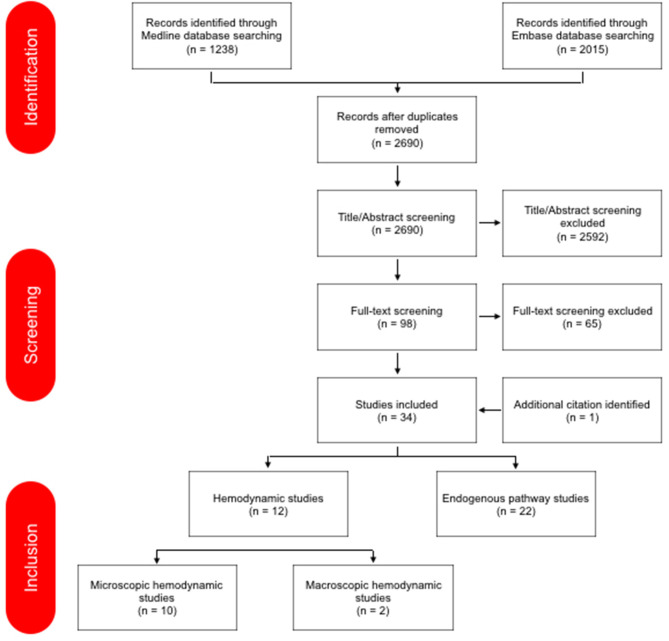
PRISMA flow diagram of the study selection (10).